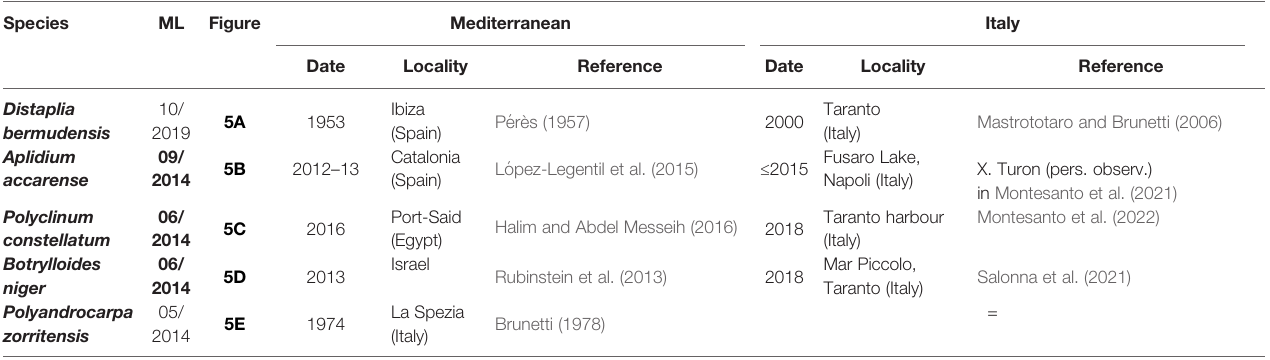
Records (ML) backdating NIS arrival in Italy and/or in the Mediterranean Sea highlighted in